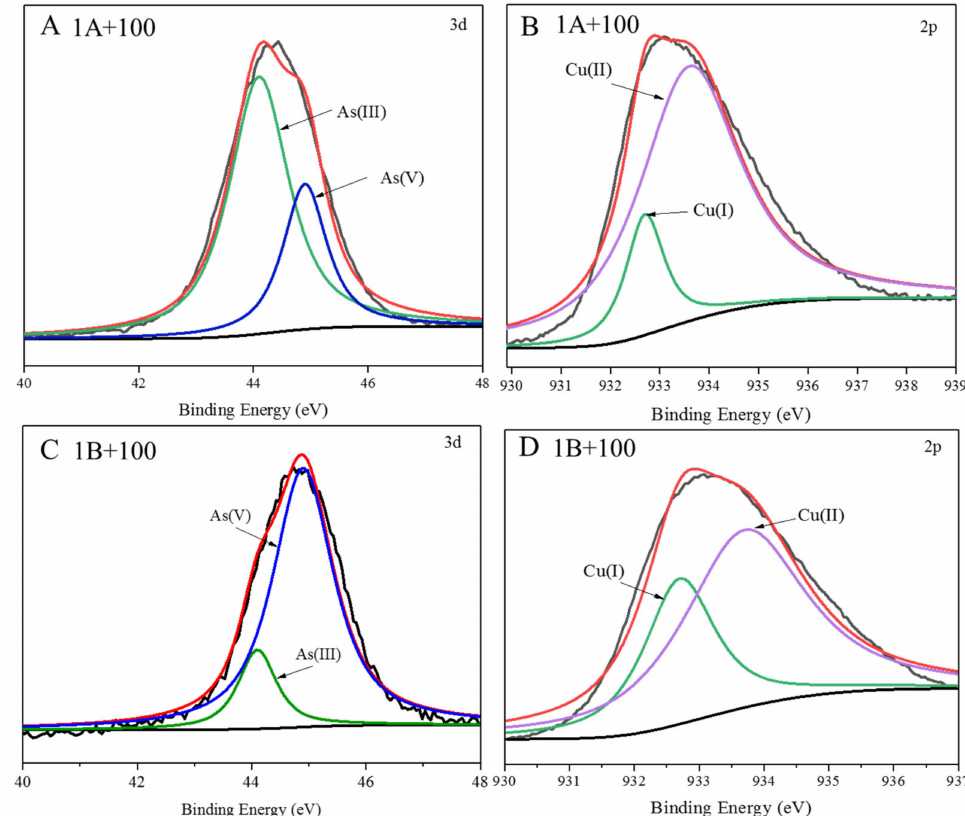
Figure 1. Species of As and Cu on the surface of CuO NPs as determined by XPS. Spectra of CuO NPs with As(III) exposure ( A , B ) and As(V) exposure ( C , D ). The green and blue line in A and C images were represented As(III) and As(V) respectively; the green and purple line in B and D images were represented Cu(I) and Cu(II)